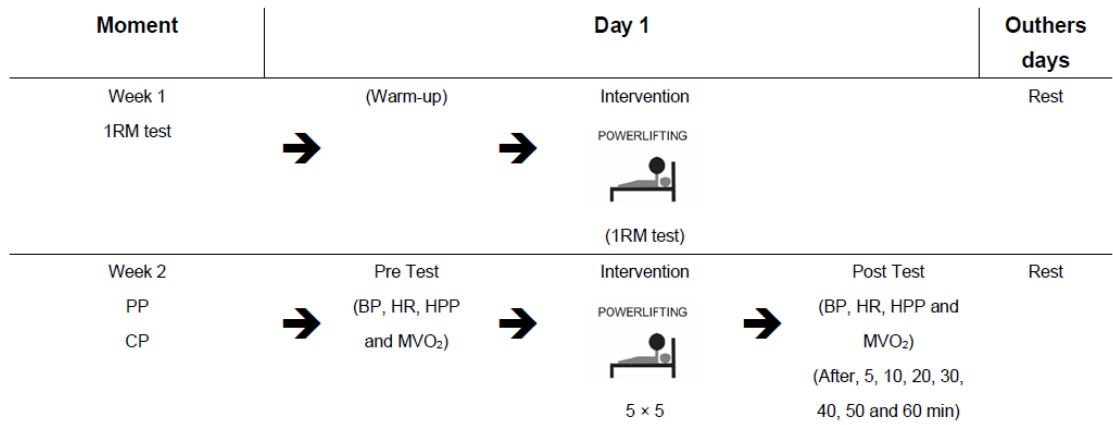
Figure 1. Experimental design—weekly schedule of the tests and intervention. BP: blood pressure, HR: heart rate, HPP: heart pressure product, MVO ₂ : myocardial oxygen volume, PP: Paralympic powerlifting. CP: conventional powerlifting, 5 × 5: five series of five maximum repetitions. Table 1. Characterization of the